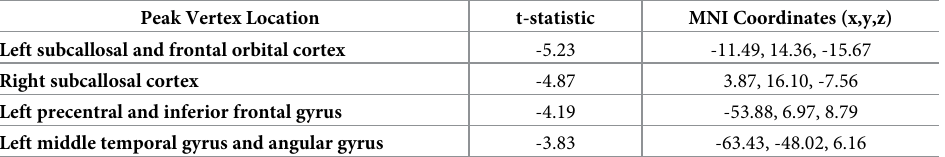
Table 3. Peak areas from person-centered analysis. Peak areas in which local cerebral cortical thickness was signifi- cantly reduced in the “high reactive” group relative to all other